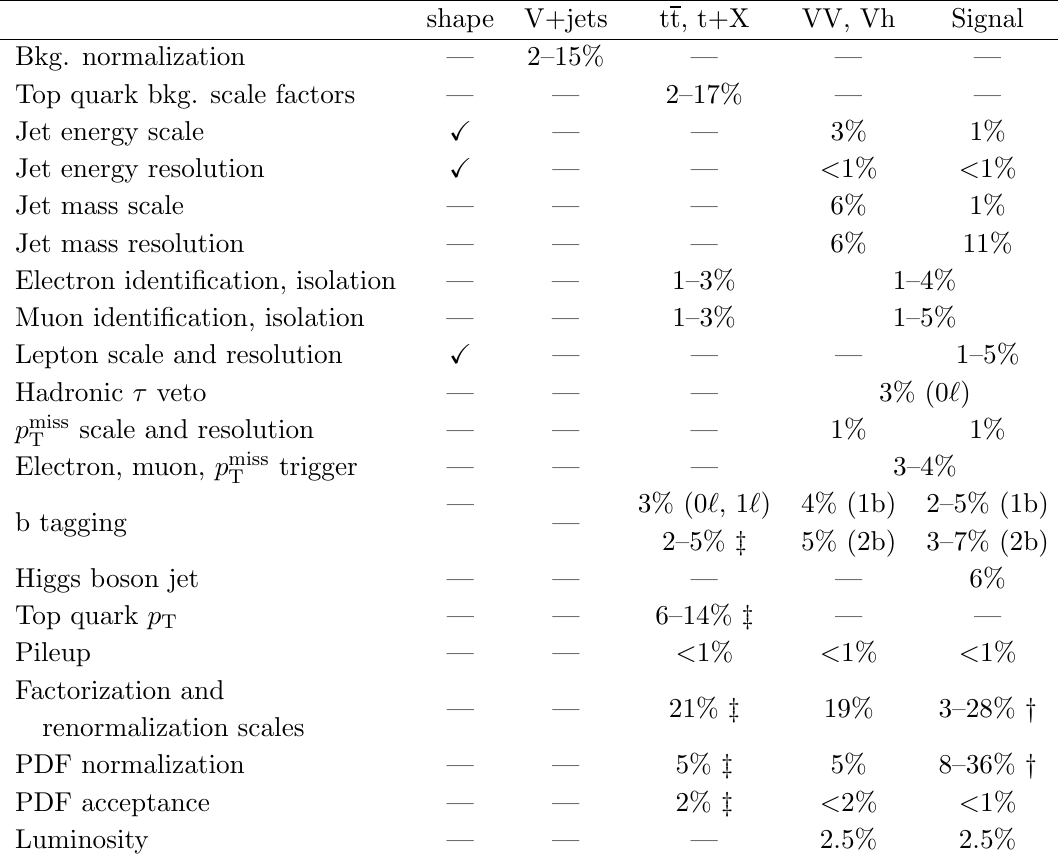
Table 3 . Summary of systematic uncertainties for the backgrounds and signal samples. The entries labeled with X are also propagated to the shapes of the distributions. The uncertainties marked with have impact on the signal cross section. Uncertainties marked with y quark background scale